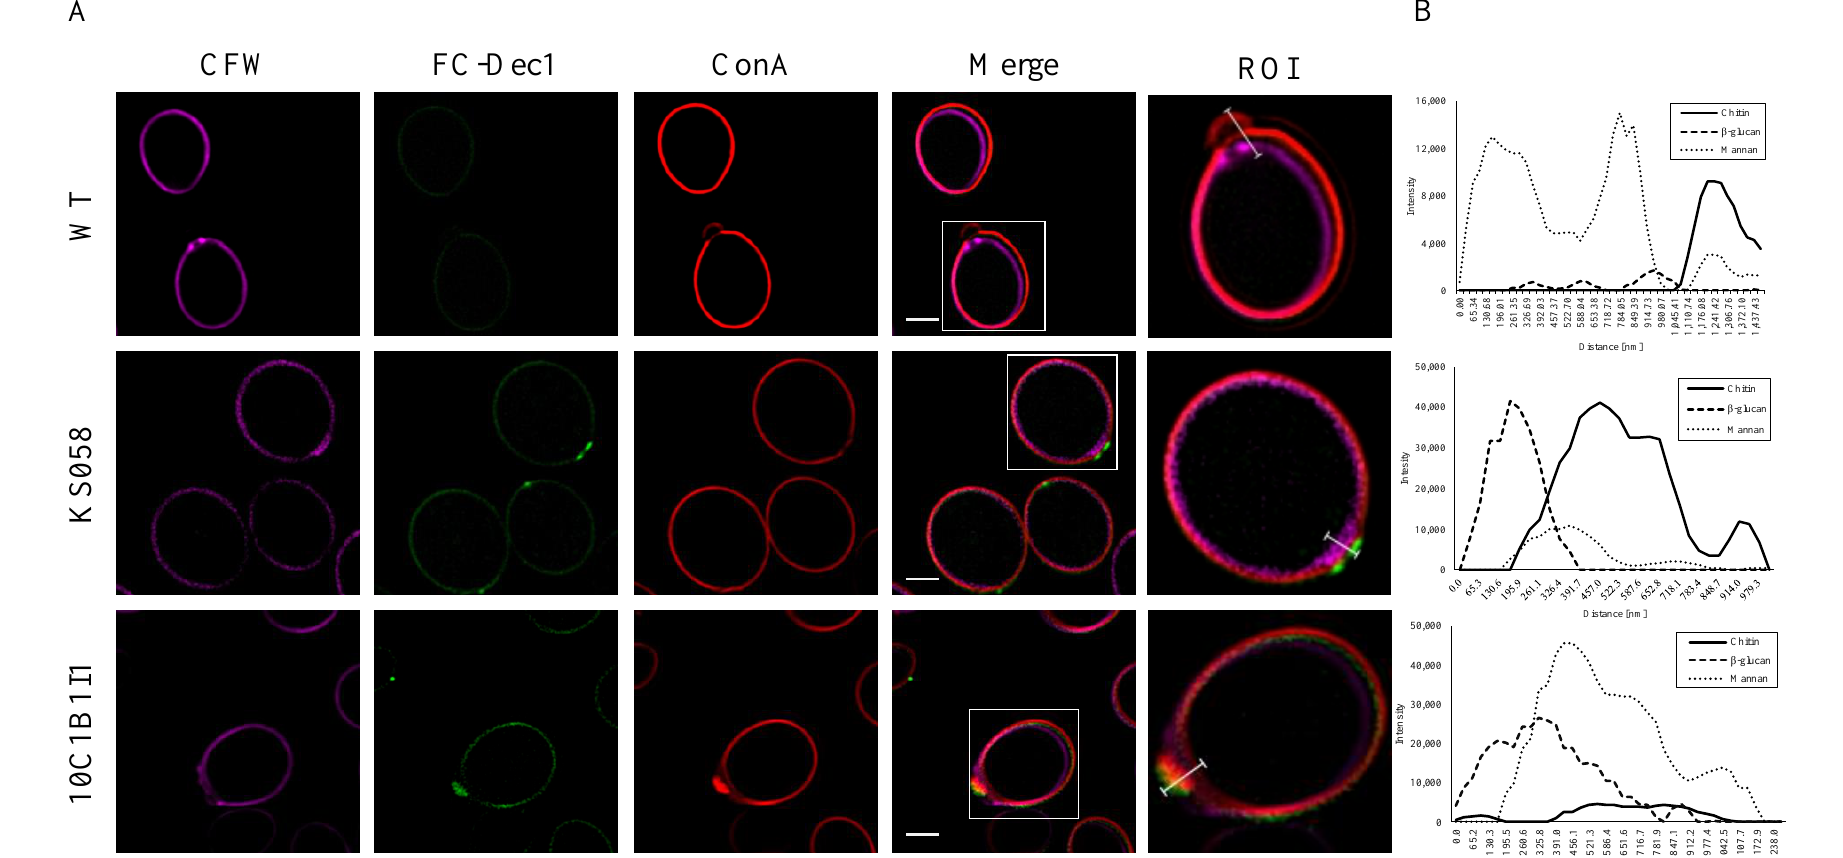
Figure 4. Triple staining of the C. albicans cell wall components for the SC5314 wild type (WT), erg11 ∆ / ∆ (KS058), and ERG11 K143R/K143R (10C1B1I1) strains ( A ). Total chitin was detected using calcofluor white (CFW) (purple). Exposed β -glucan was stained with Fc-hDectin-1 (FC-Dec1) and Alexa Fluor 448-conjugated anti-human IgG Fc antibodies (green). Mannans were detected using streptavidin and concanavalin A (ConA) conjugated with Alexa Fluor-568 (red). Scale bars of all presented images are equal to 2 µ m. White squares on the merged picture represent region of interest (ROI). Fluorescence intensities for particular CW components for ROI (regions of bud scars; white lines) for investigated C. albicans strains ( B ). The distance [nm] between CW components is presented from outside to inside of the cell at the area of the bud